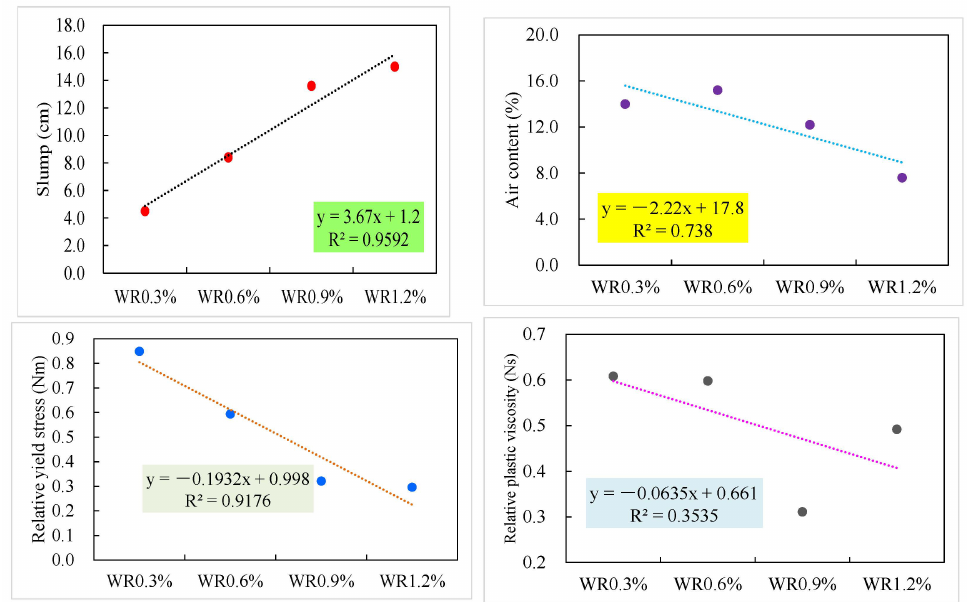
Figure 12. Effect of water reducer on slump, air content, relative yield stress, and viscosity.